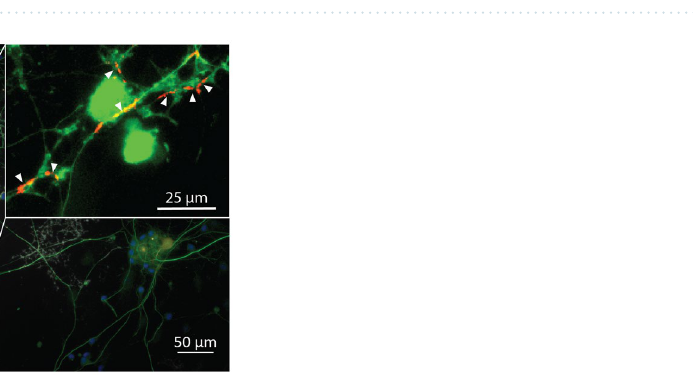
Figure 4. Higher concentrations of BQ3020 and XAV939 increase the total length of myelinated axons in vitro . Quantification of total myelinated axon length (µm/well) of ( A ) BQ3020 (1–500 ng/ml) and ( B ) XAV939 (1–5000 ng/ml) compared to DMSO control. Individual values show mean ± SEM; 4 biological replicates were done, analysis was done by unpaired t-test with 95% confidence interval, ns not significant, *P < 0.05, **P < 0.01, ***P < 0.001, ****P < 0.0001.